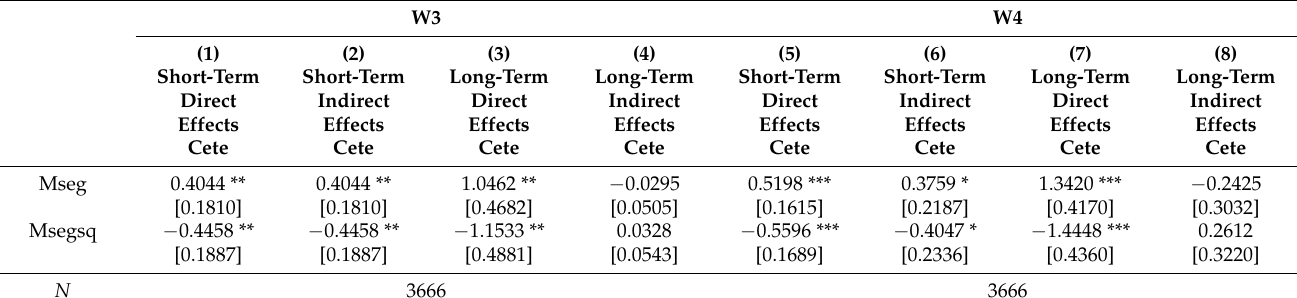
Table 8. Estimation of direct and indirect effects under different spatial weight